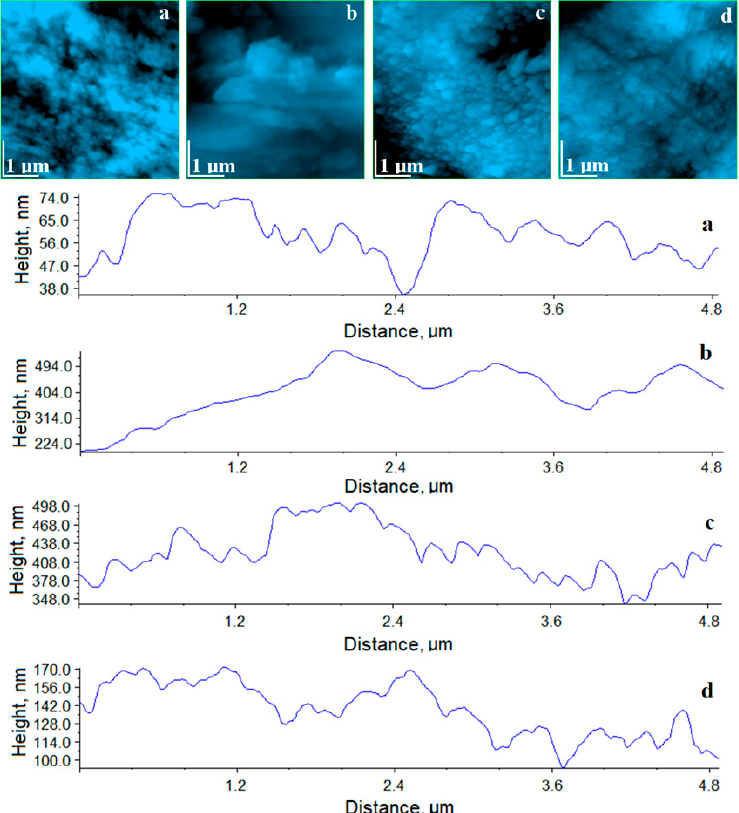
Figure 11. AFM topographic images of the fine microstructure of the samples: ( a ) healthy, untreated enamel, ( b ) stained enamel with coffee, ( c ) stained enamel and then treated with Opalescence gel, and ( d ) stained enamel and then treated with experimental bleaching gel. Two-dimensional profiles on the horizontal median of the topographic images are given. They are related to the roughness at the fine microstructure level, “Ra micro” in Table 2.